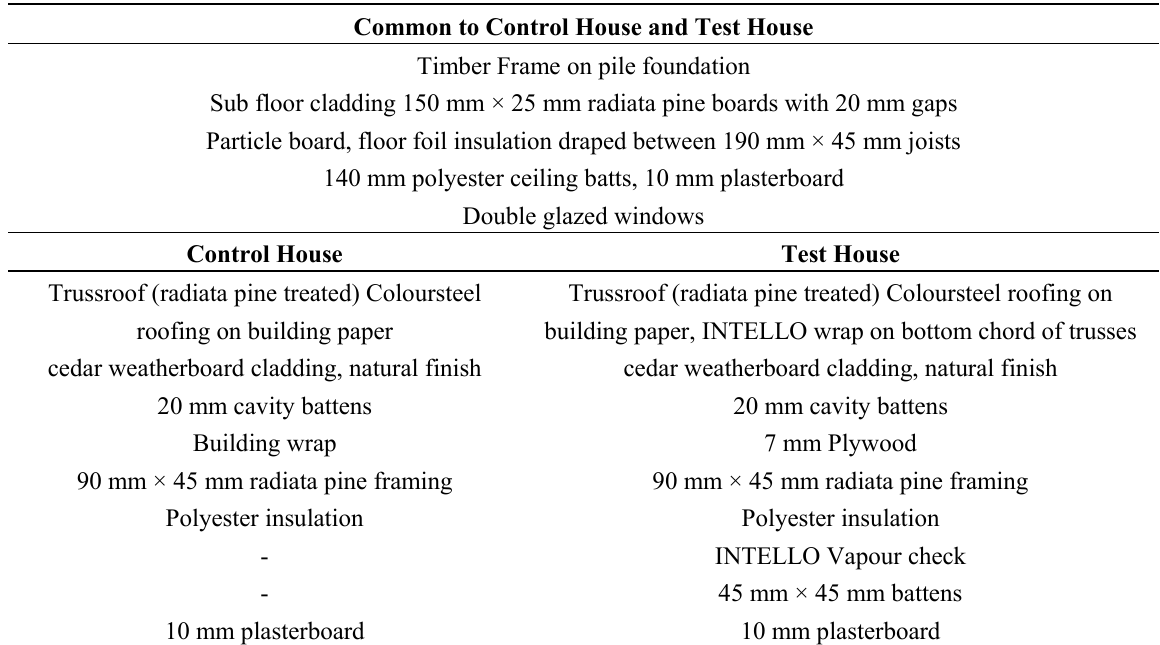
Table 1. Construction details for the control and test houses.